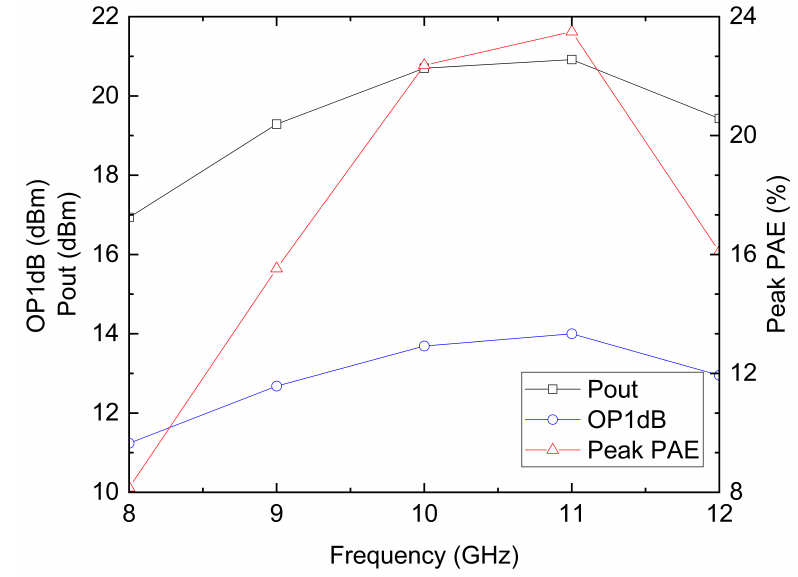
Figure 15. Measured power performance of the X-band PA for frequency range 8–12 GHz in steps of 2 GHz.